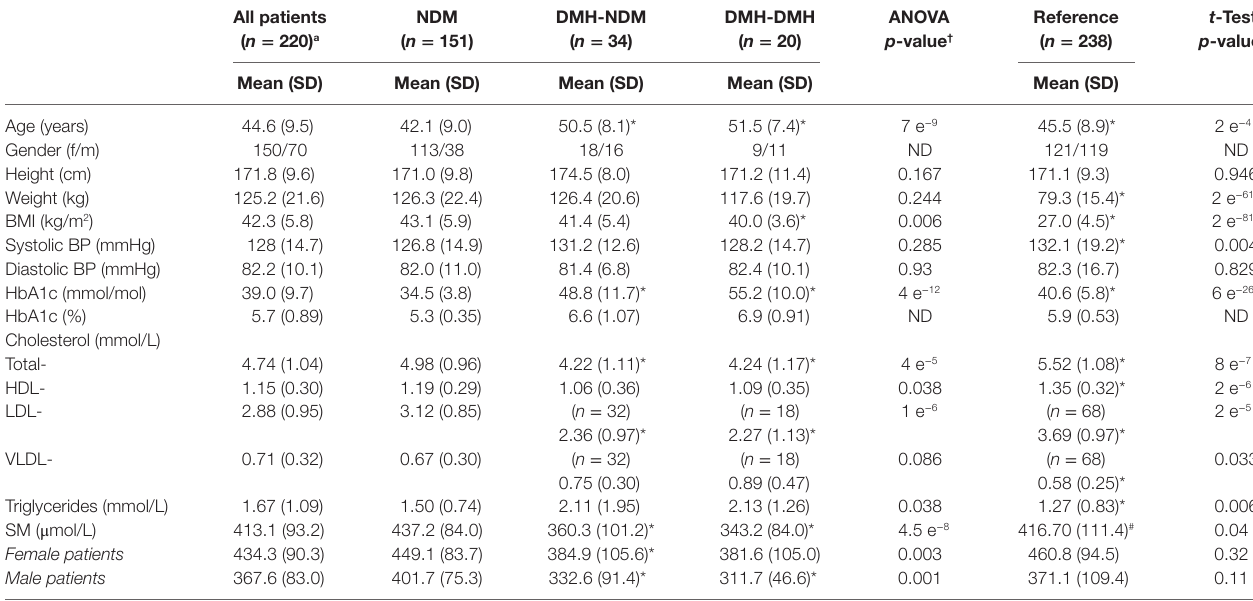
TaBle 1 | Preoperative clinical characteristics and sphingomyelin (SM) concentration for all patients and patients grouped according to diabetes status, alongside a normal weight reference population.